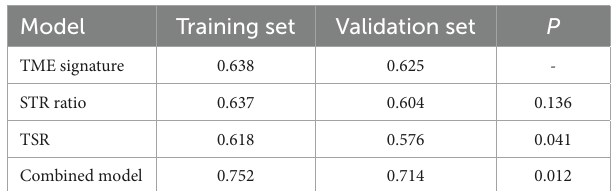
TABLE 3 C-index of different models.